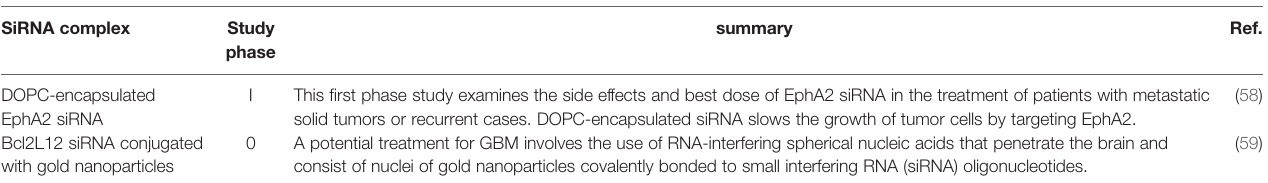
TABLE 4 | Clinical trials on siRNAs for